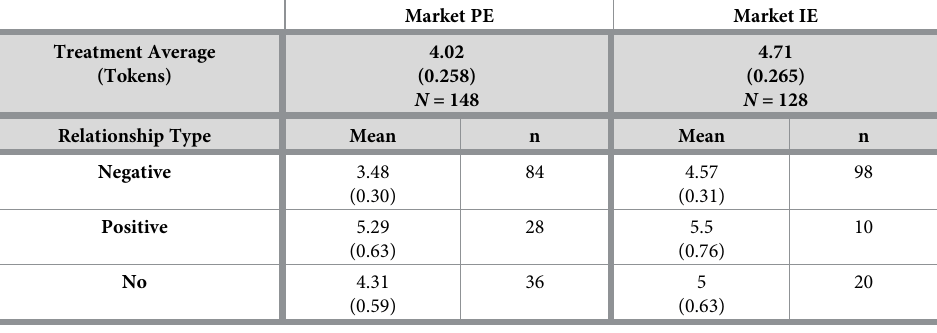
Table 1. Summary of Player 1 transfers in Markets PE and IE by relationship